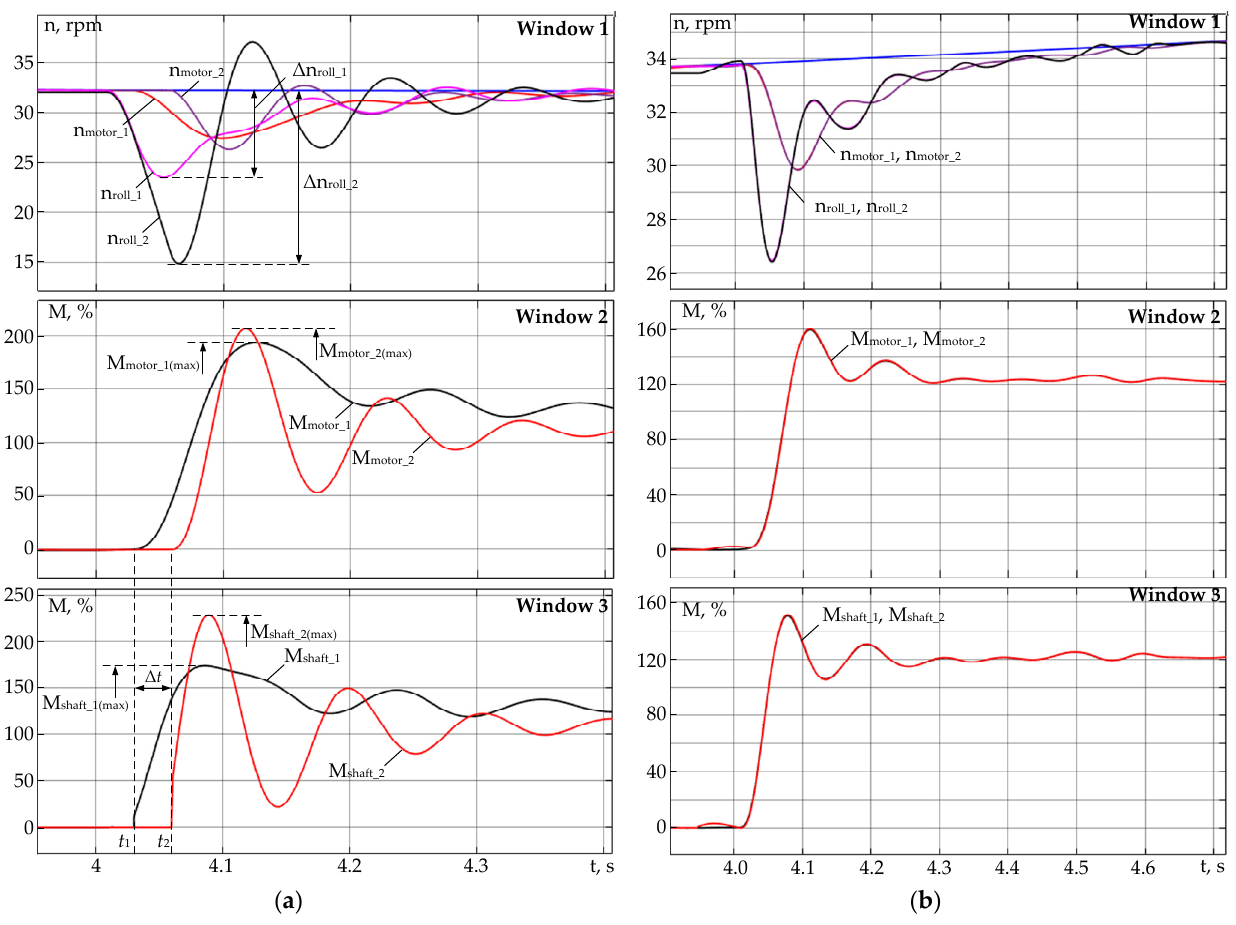
Figure 10. The UMD and LMD spindle motor speed (windows 1), torque (windows 2), and elastic torque (windows 3) oscillograms for open ( a ) and closed ( b ) angular gaps. Table 3. Dynamic torque deviations of the motor and shaft when biting.